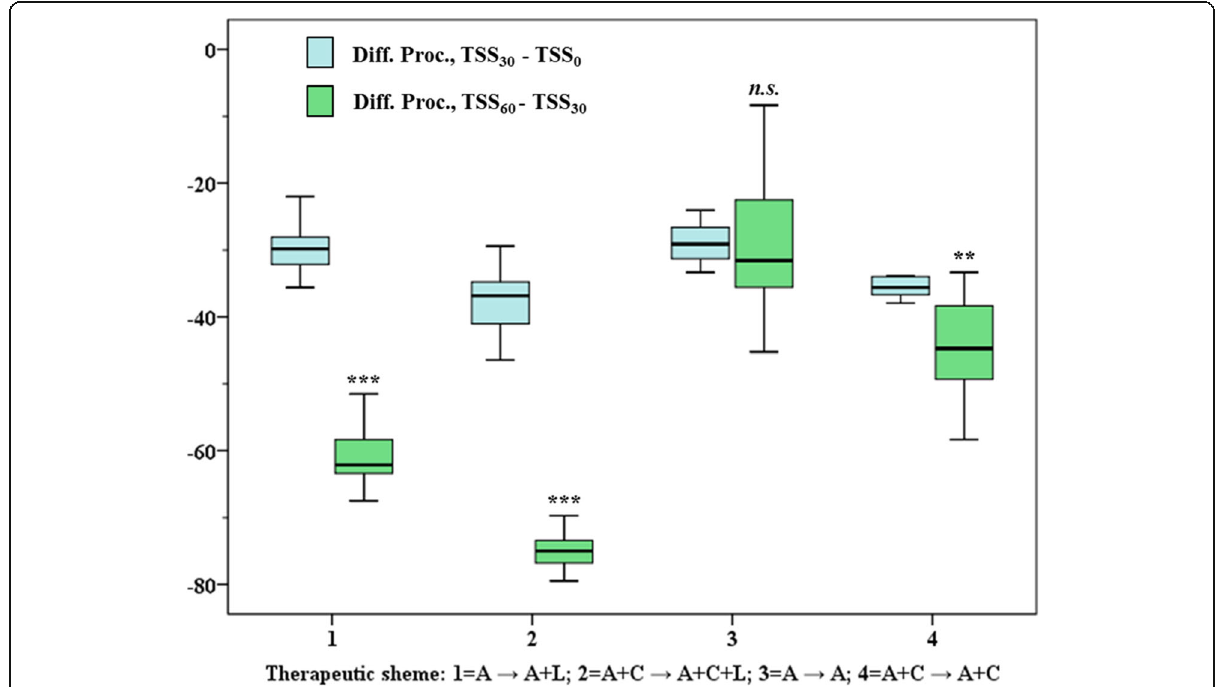
Fig. 1 Graphical presentation of differences in the percents of improvement in TSS (day 30 vs day 0; day 60 vs day 30) for 4 different treatment modalities. ** p < 0.01; *** p < 0.001 vs corresponding TSS 30 – TSS 0